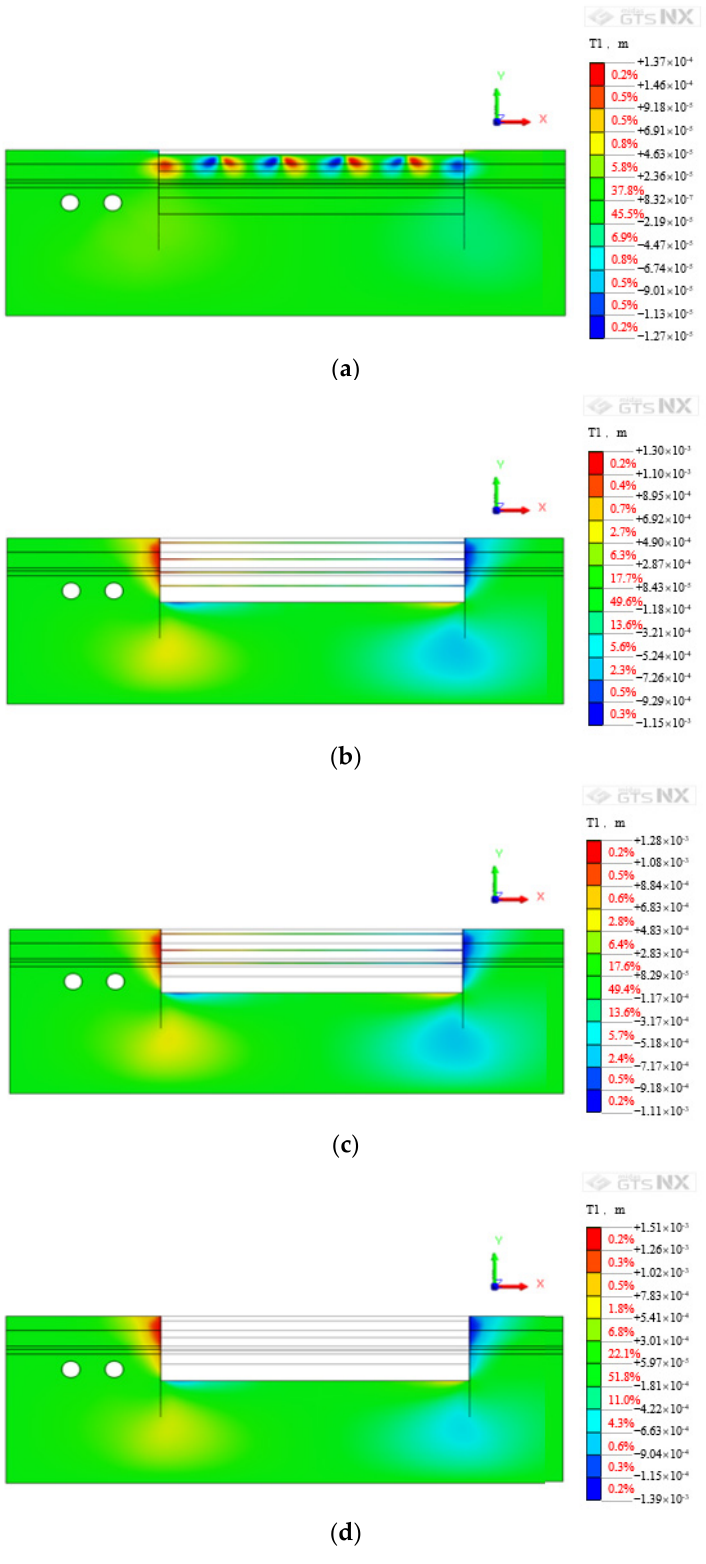
Figure 12. Horizontal deformation subway tunnel caused by construction of section B . ( a ) Excavate to − 2.20 m elevation. ( b ) Excavate to the design elevation of the bottom of the foundation pit. ( c ) The inner supports on the fourth layer are removed. ( d ) All inner supports are removed.